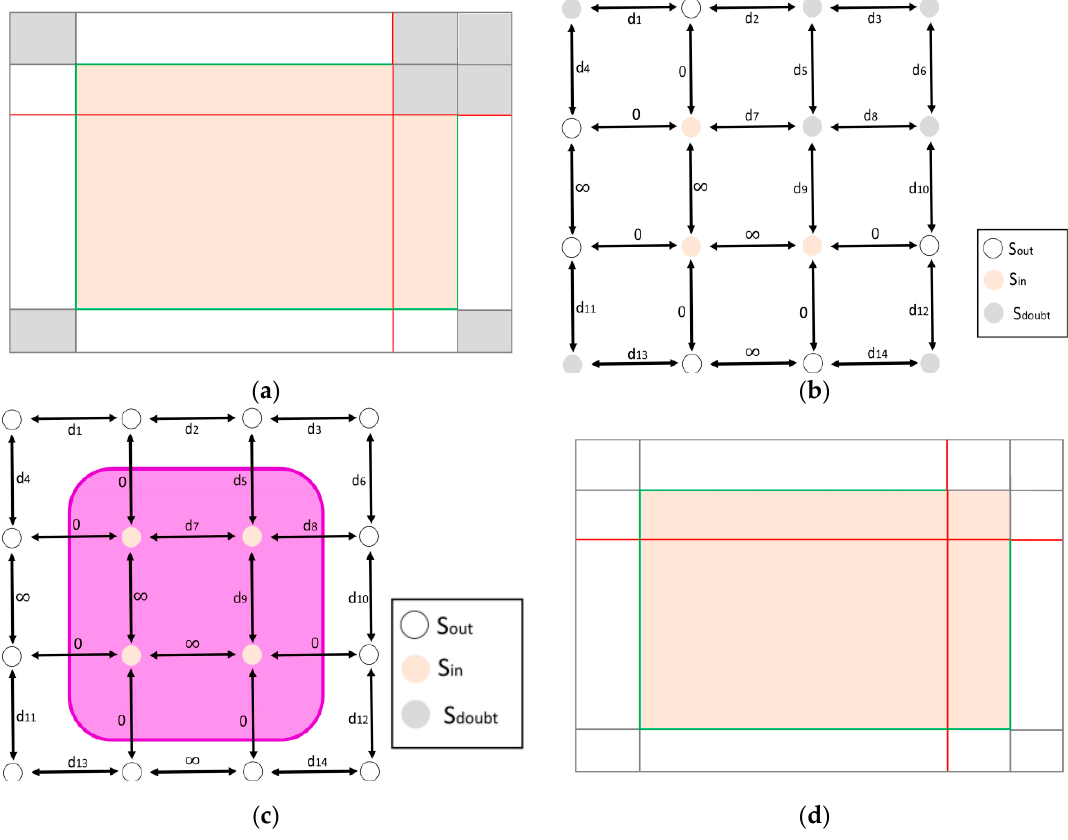
Figure 5. Example of indoor component reconstruction using ‘s–t cut’ for Room 1: ( a ) initial labelling considering ceiling occupancy, ( b ) graph construction and cost assignment; ( c ) final binary labeling with minimum cost; and ( d ) final complex labeling.